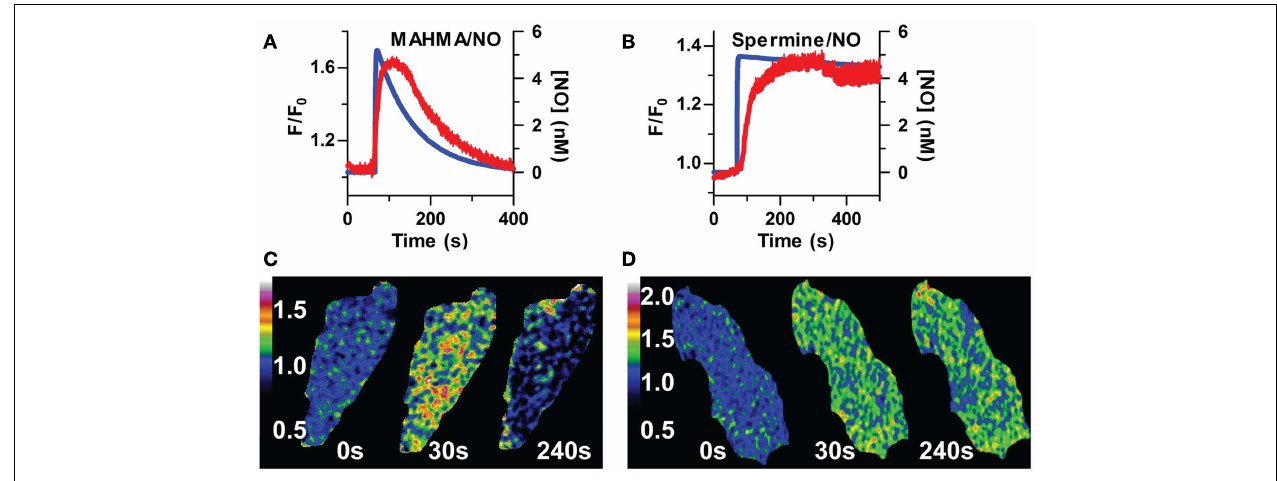
cGMP). (A) MAHMA/NO ( n = 8), (B) Spermine/NO ( n = 9). Distribution of [cGMP] i in response to NO, both transient (C) and sustained (D) , is globally dispersed throughout the cytoplasm (60 × magnification, see Methods).